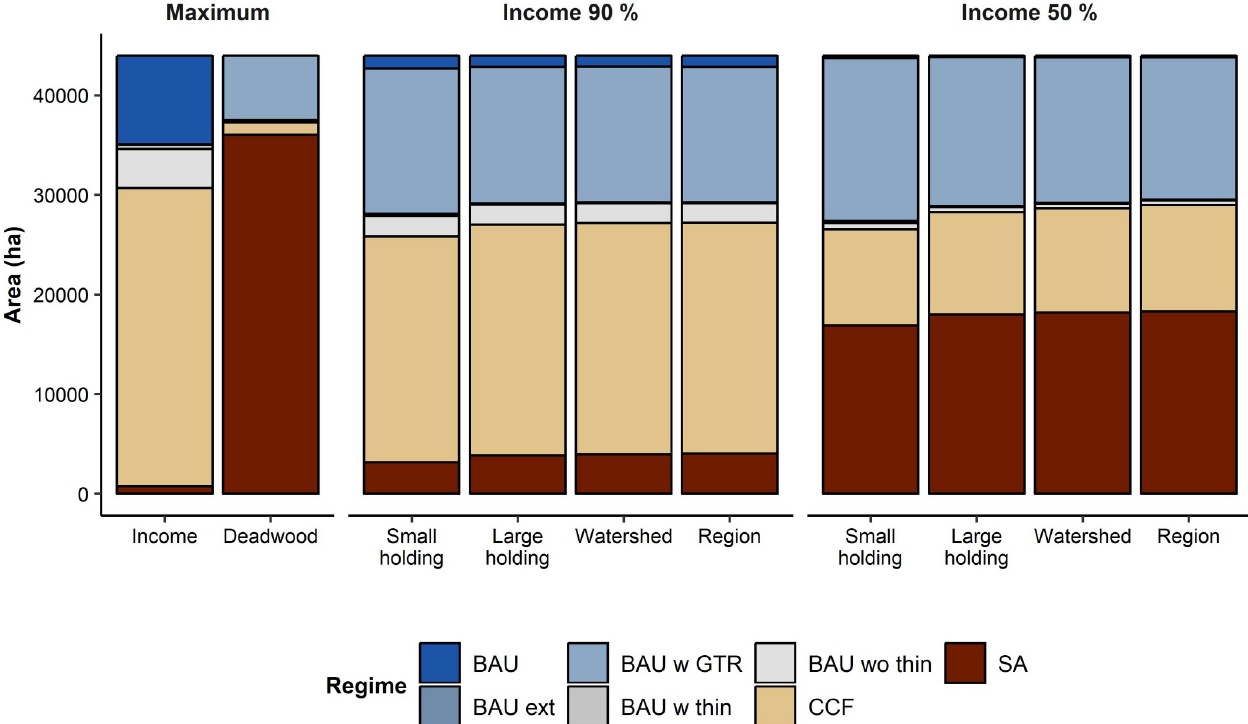
Fig 6. Distributions of management regimes. The distributions of management regimes that maximize the two objectives (‘Income’ and ‘Deadwood’) or provide the optimal outcomes at harvest income requirements of 90% and 50% when management regime allocation is optimized at different spatial scales (‘Small hold.’ for the ‘small holding’ scale and ‘Large hold.’ for the ‘large holding’ scale). For visual clarity, the 16 modified versions of ‘business-as-usual’ management (see Methods) have been grouped into 4 categories based on their defining features (extended rotation time, green tree retention, thinnings before final felling, or no thinnings). The abbreviations in the legend refer to: BAU—business-as-usual; BAU ext—business-as-usual with extended rotation time; BAU w GTR—business-as-usual with green tree retention; BAU w thin—business-as-usual with thinning before final felling; BAU wo thin—business-as- usual without thinnings; CCF—continuous cover forestry; and